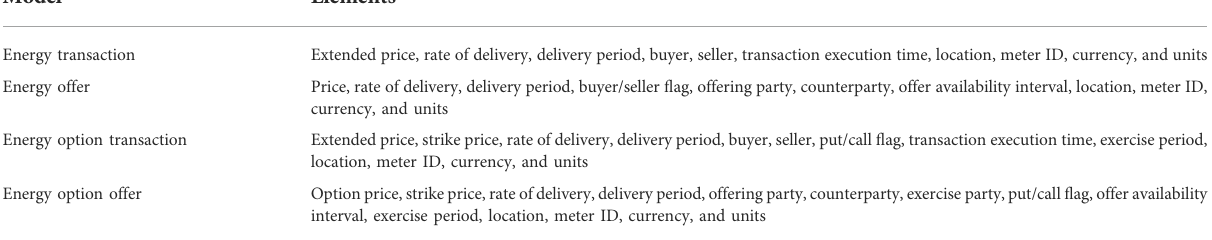
TABLE 2 Elements of the four information models (Cazalet,